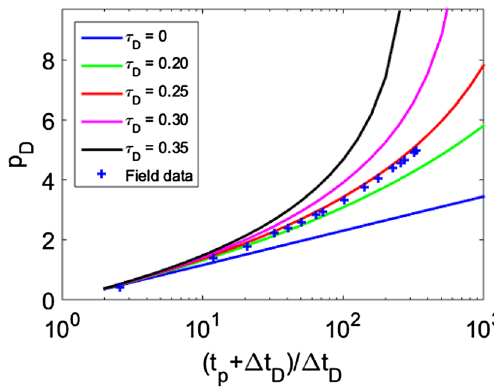
Fig. 7 Kikani and Pedrosa (1991) result reproduced by the general- ized model, their results are indicated by symbol